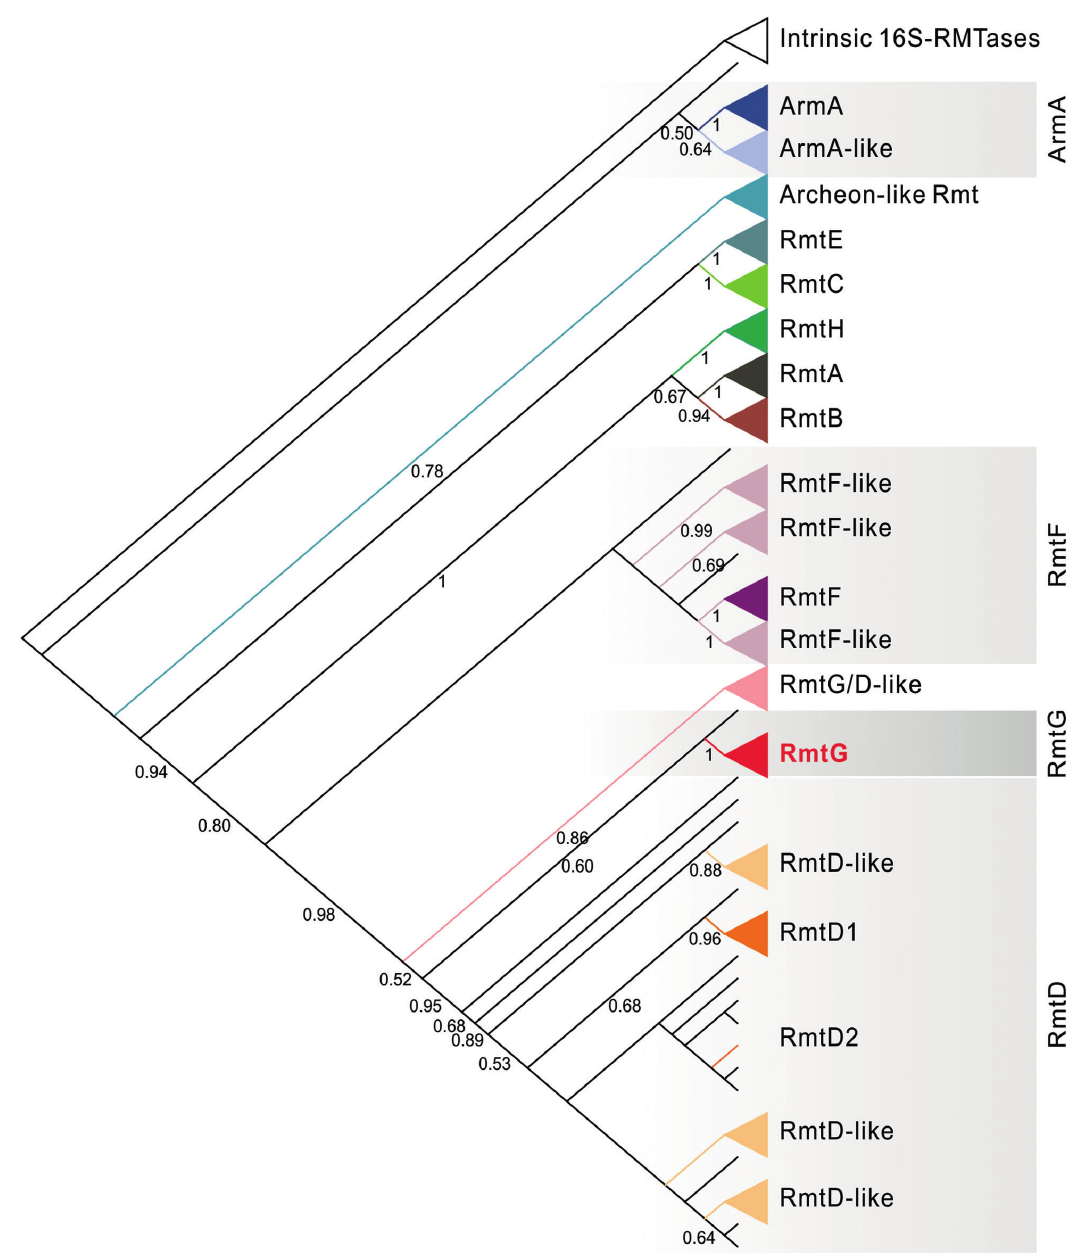
Figure 2 - Phylogenetic reconstruction of 16S rRNA methyltransferases. Intrinsic 16S-RMTases were arbitrarily used as outgroups. labels at internal nodes represent bootstrap support values. Nodes with support values lower than 0.5 were not labeled. Clades containing canonical 16S-RMTases were collapsed (in solid colors) at a minimum bootstrap threshold of 0.8, except for Intrinsic 16S-RMTases, ArmA-like and RmtD/F-like clades (which were collapsed for better visualization, even with low support). RmtB1 and RmtB2 formed a monophyletic group and were collapsed into the RmtB clade. We have not found strong support for the separation of the RmtD1 and RmtD2 clades, although the monophyly of the RmtD group is supported. The suffix “-like” were used for clades containing potentially new subfamilies of 16S-RMTases derived from the metagenome study reported by Pehrsson et al. (2016) (except ArmA- like). These clades are represented in light versions of colors used for the clades containing their canonical counterparts. Notably, these metagenome sequences are restricted to the Rmt(F, g/D, D)-like